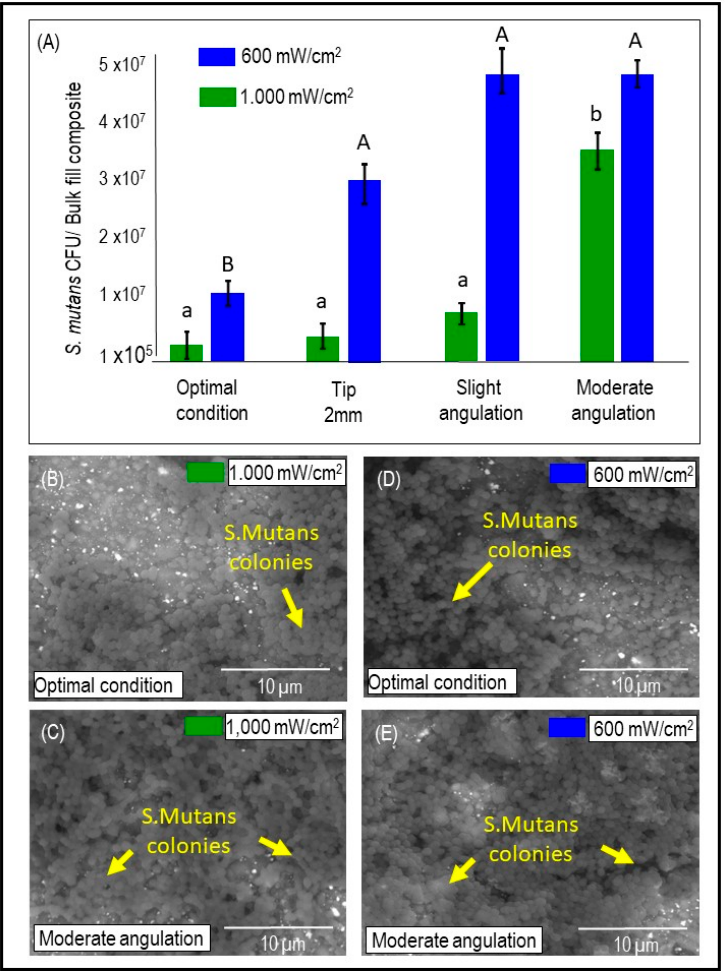
Figure 5. The quantitative and qualitative analysis of the S. mutans biofilm grown over the bulk-fill (BF) composites cured in different conditions. ( A ) S. mutans colony forming units (CFU) growth over the BF composites for each LCU output and each light-curing condition (mean ± sd; n = 6). ( B – E ) Representative SEM images showing bacterial adhesion and biofilm formation on the bottom surfaces of composite cylinders for LCU 1000 ( B , C ) and LCU 600 ( D , E ) under optimal and moderate angulation conditions. Note arrows point to the S. mutans colonies. Capital letters compare LCU 600 , while lower case letters compare LCU 1000 . Dissimilar letters are significantly different from each other ( p <